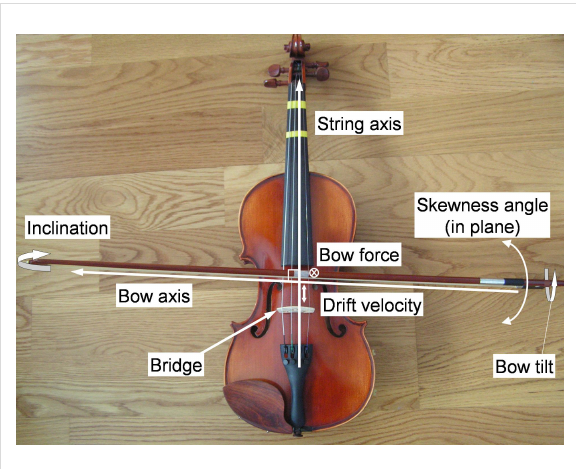
Figure 1: Scheme of the different parameters involved in violin